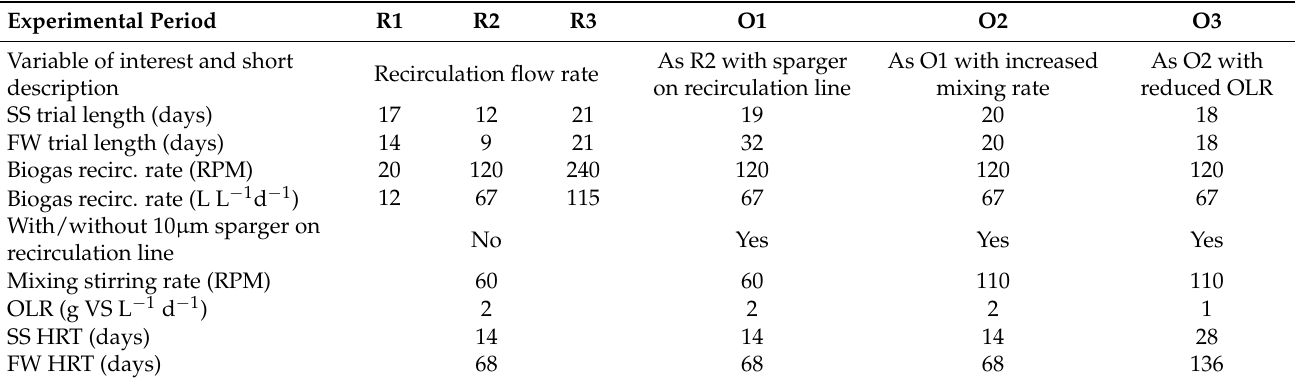
Table 3. Summary of experimental